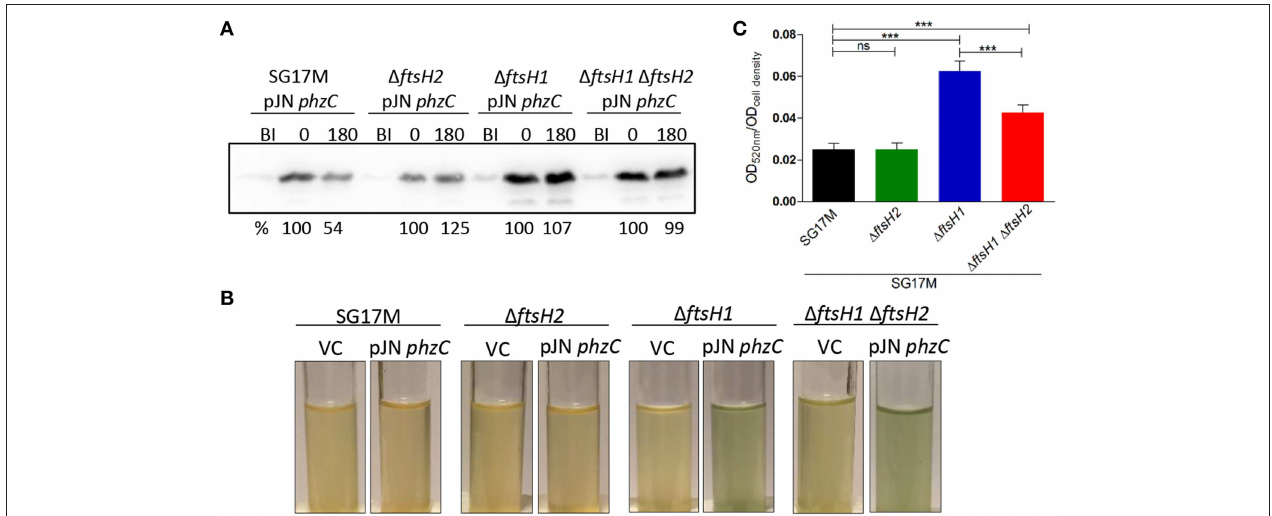
FIGURE 6 | Degradation of PhzC-6xHis is ftsH1 -dependent in P. aeruginosa SG17M. (A) In vivo degradation assay at 37 ◦ C in the logarithmic growth phase. BI (Before Induction) refers to the sample before inducing the production of PhzC. Numbers above the blot represent time in min after the termination of translation with